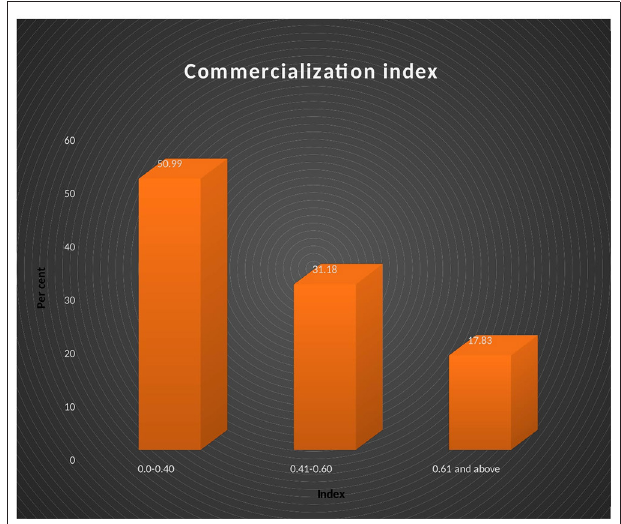
FIGURE 1 | Distribution of the commercialization index of indigenous crops.